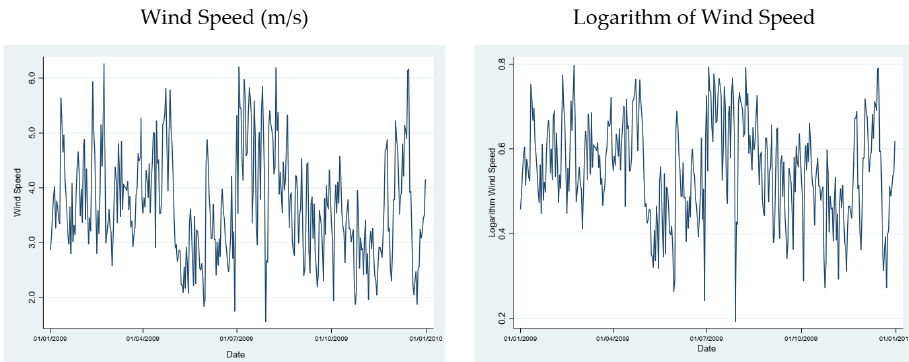
Figure 2. Wind speed (m/s) and its logarithm for the Almirante Padilla station for 2009.